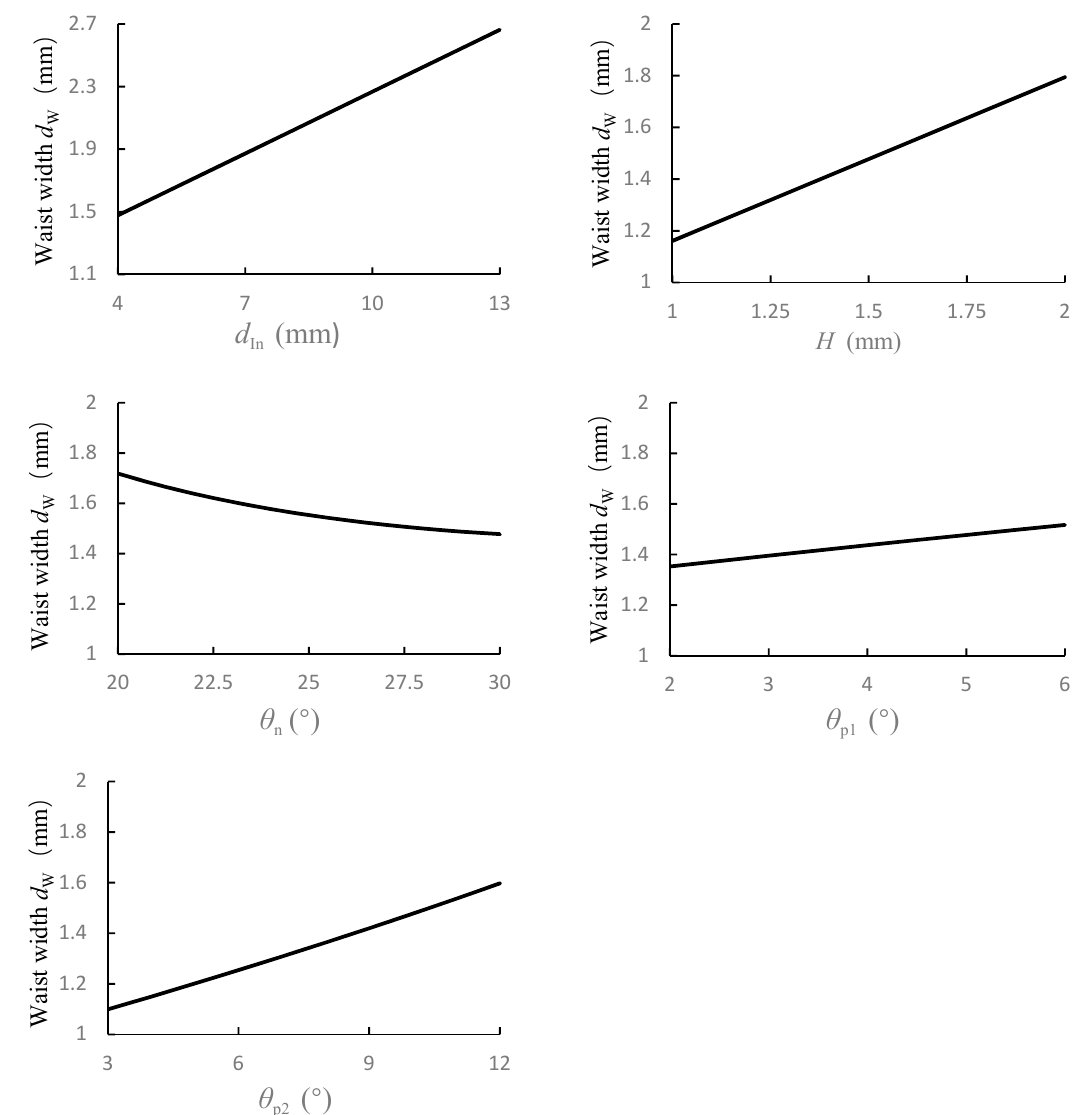
Figure 7. The effects of each parameter on the waist width d w . Table 2. Sensitivity of d W to each parameter.